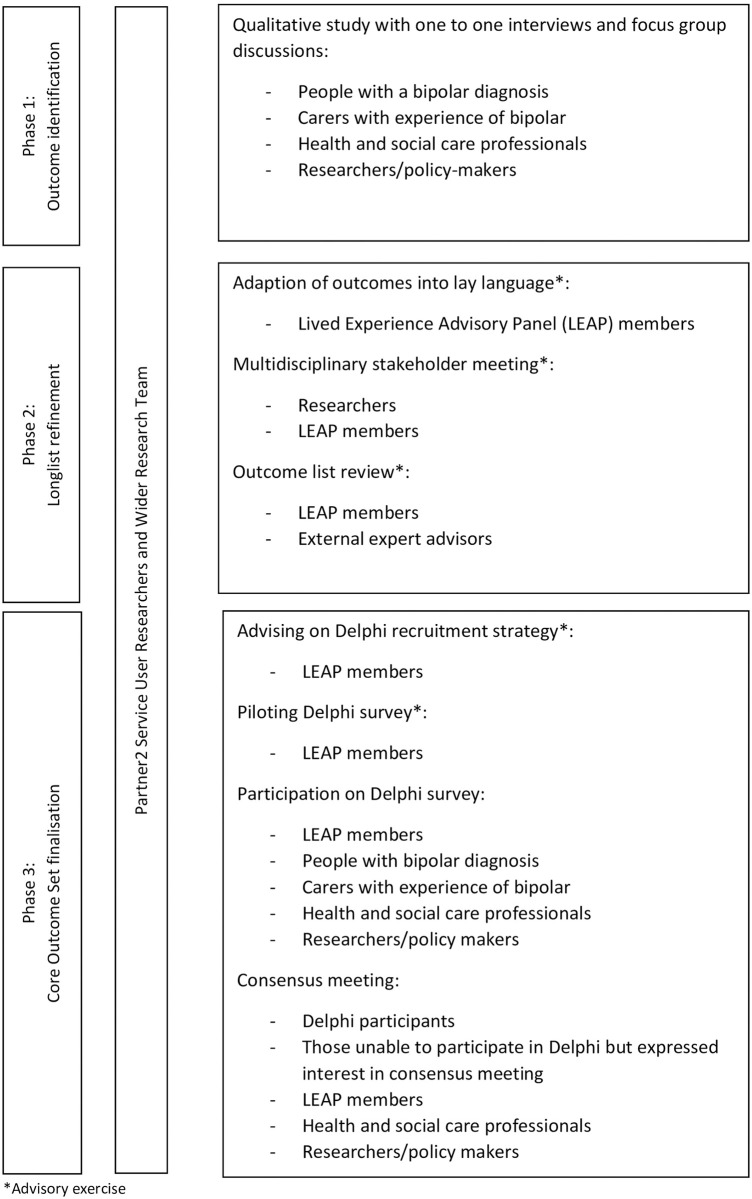
Overview of stakeholder involvement per phase.